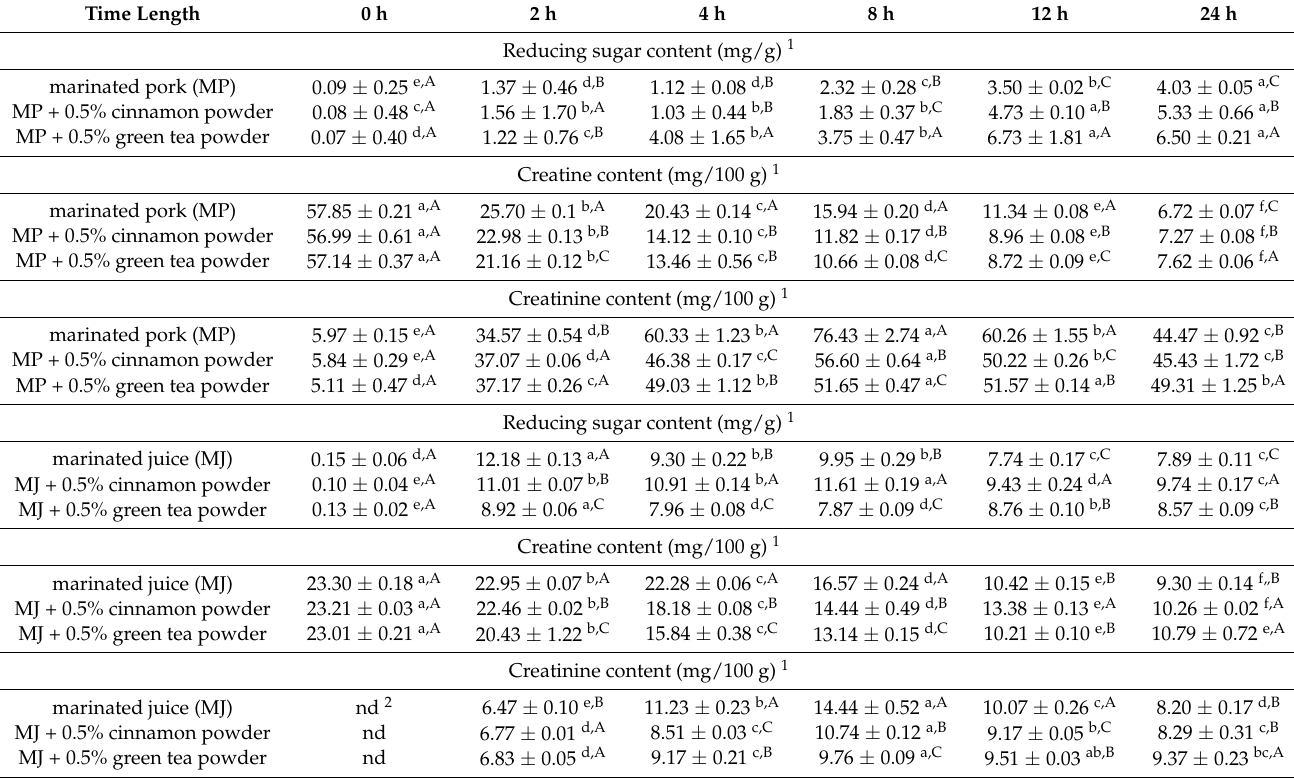
Table 3. Changes of HA precursor contents in unmarinated/marinated pork and juice as affected by different flavorings and time